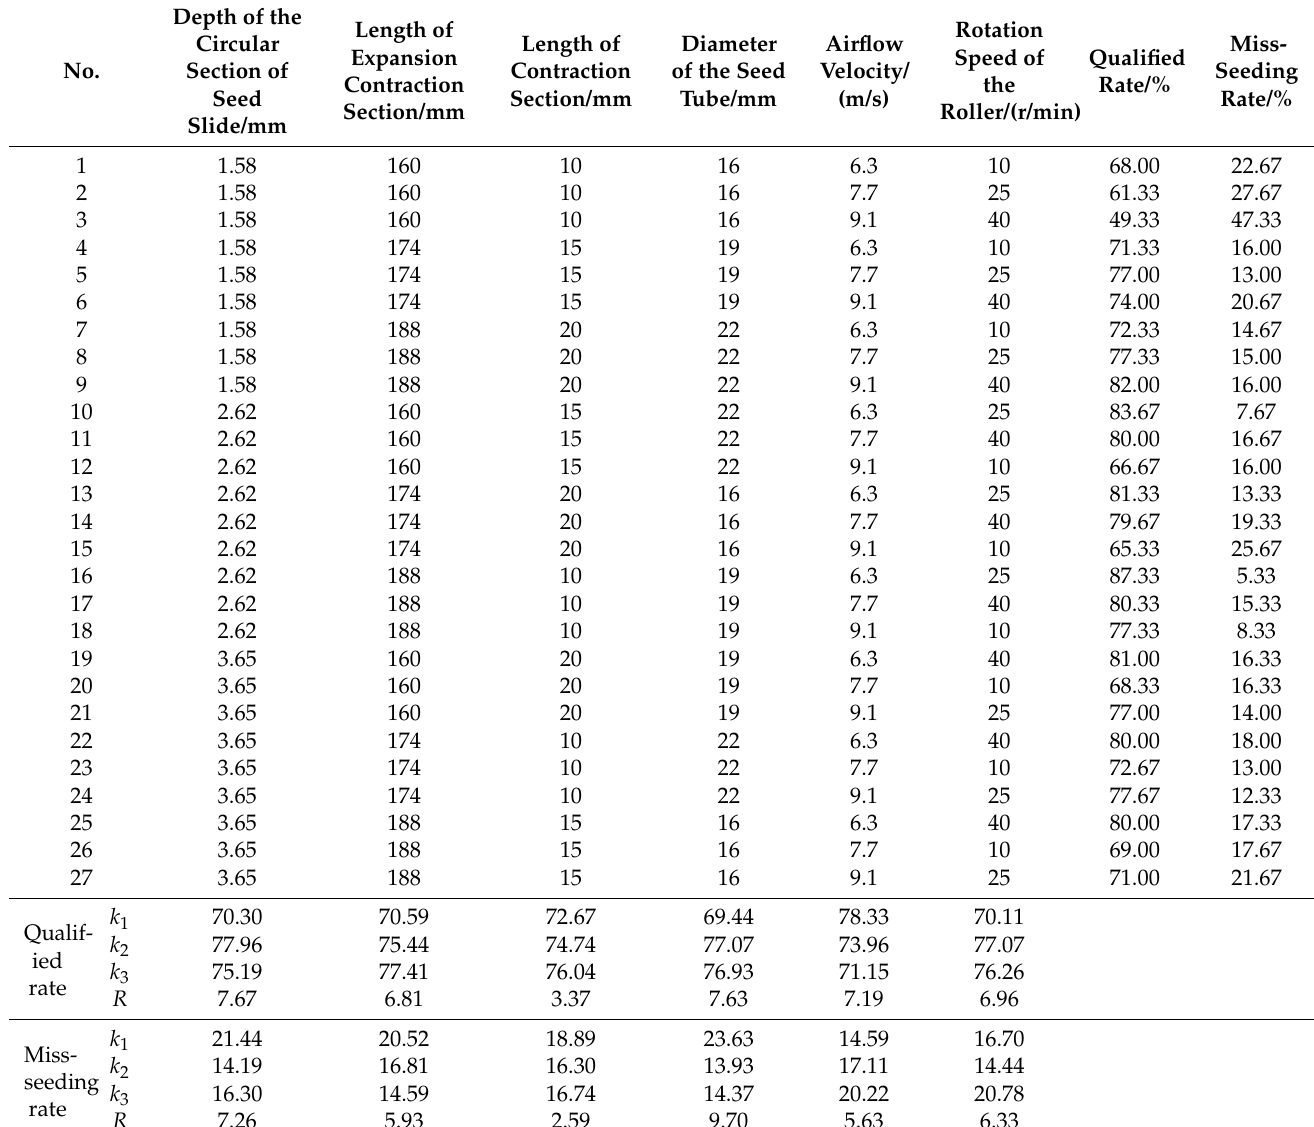
Table 2. Test scheme and